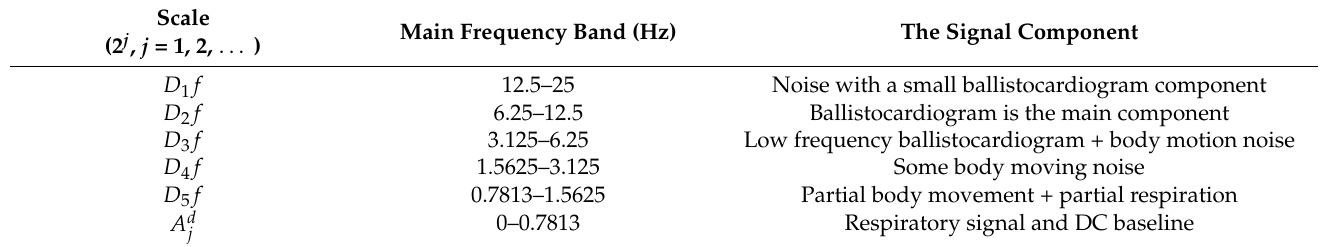
Table 2. Interval values and signal components of each part after wavelet